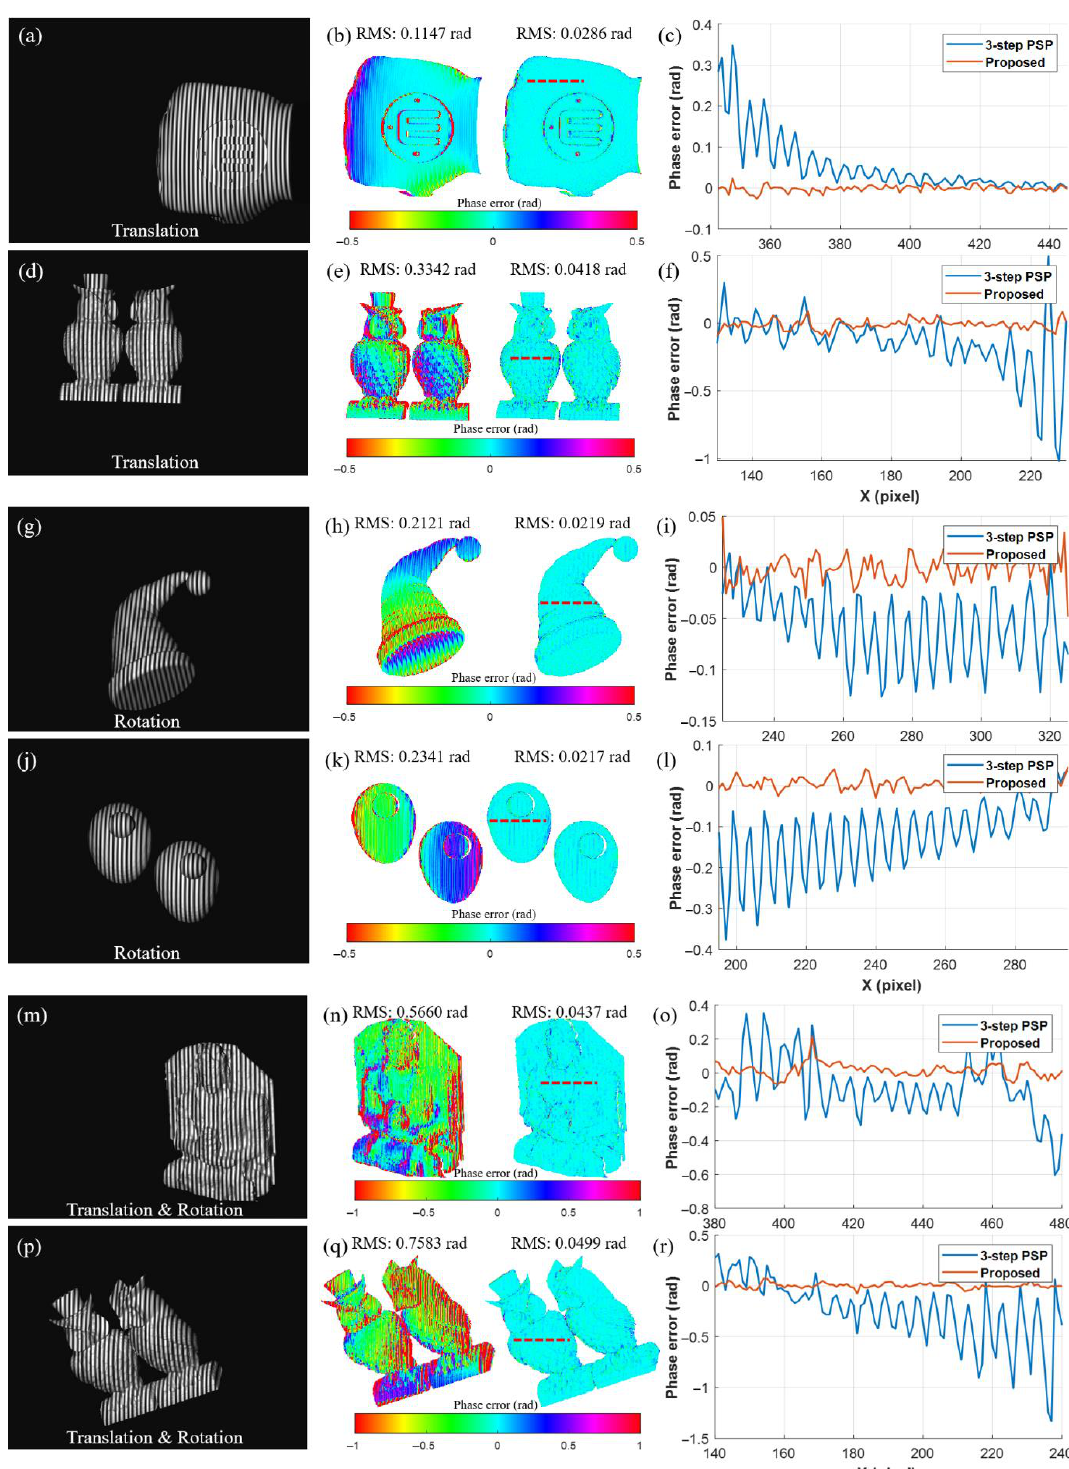
Figure 5. Measurement results of the scenes of different motion types in the validation set. ( a ) One fringe pattern of a translational fist-shaped object. ( b ) Phase error of three-step PSP (left) and proposed method (right), and their RMS errors (top). ( c ) Section line of phase errors along the red dotted line marked in ( b ). ( d – r ) Corresponding results of translational two owl sculptures, one rotating hat-shaped object, two rotating components, one translational and rotating Buddhist sculpture, and owl sculptures.